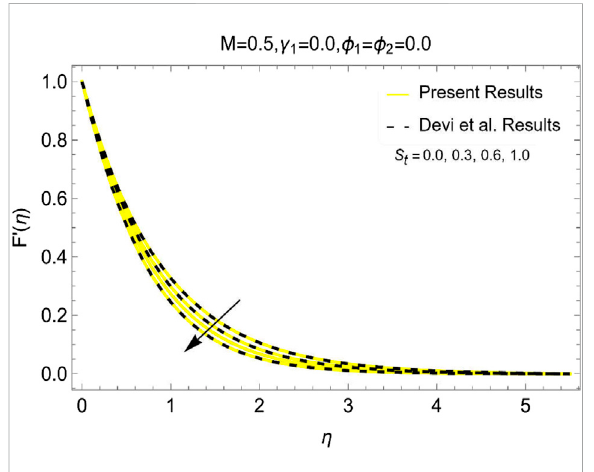
Reliability of the present analysis with previous